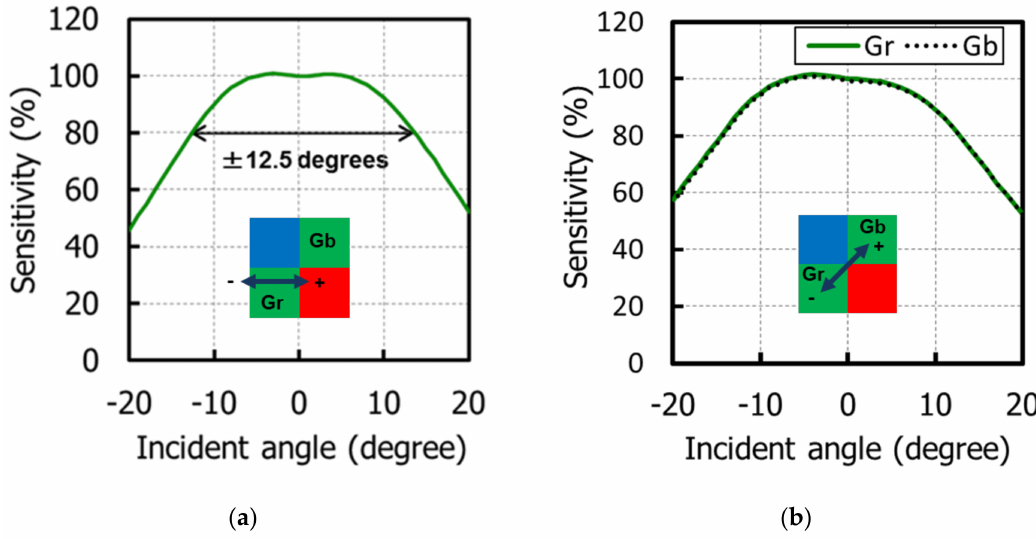
Figure 13. Normalized angularresponse ofQE in ( a ) thehorizontal directionand ( b ) thediagonal